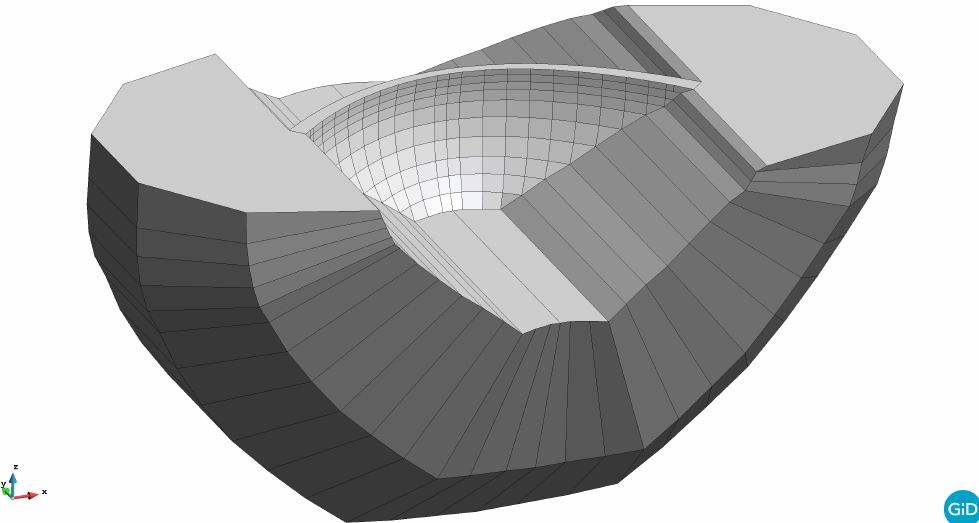
Figure 3. Overall view of the computational model for the dam body and foundation.